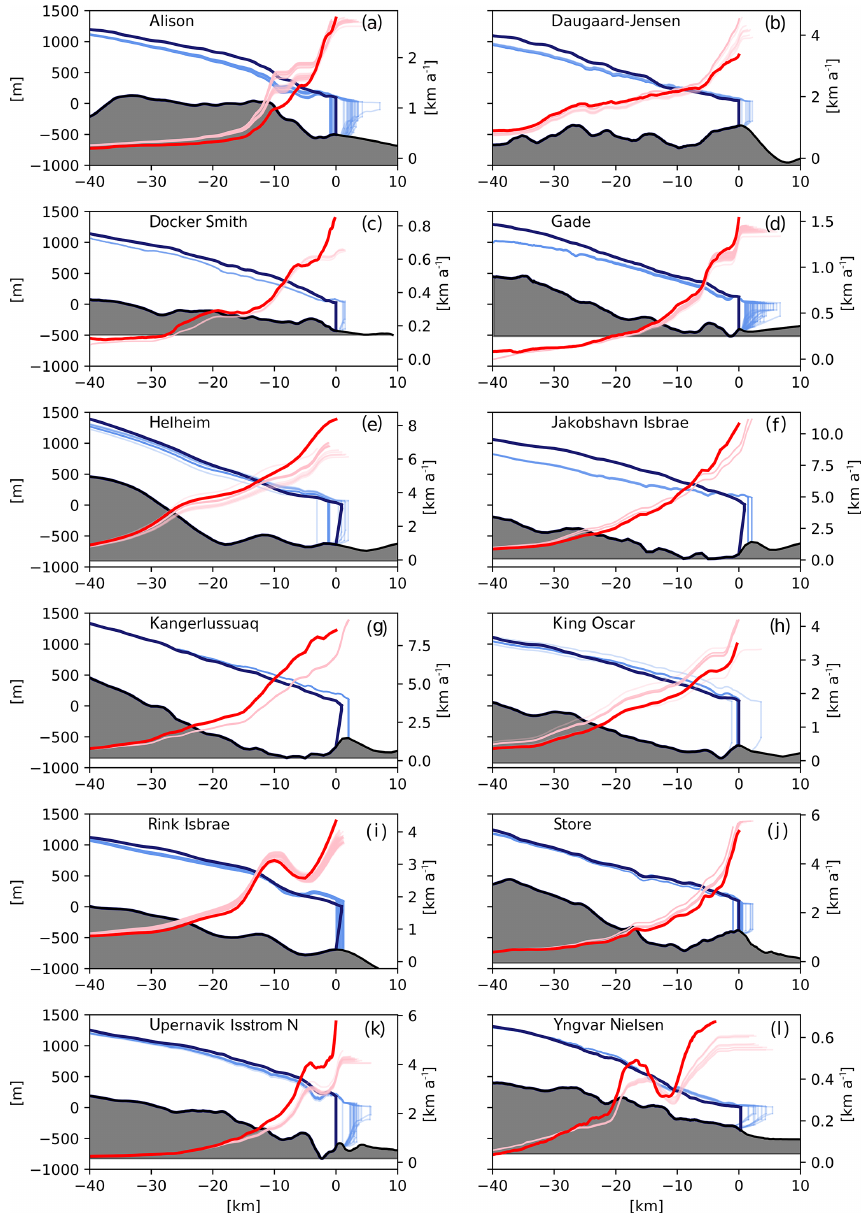
Figure 6. Simulated steady state after spin-up. Glacier elevation (light blue) and velocity profile (light red) for the last 40km to the grounding line depicted together with observational data (dark blue and dark red) by Morlighem et al. (2014) and Rignot and Mouginot (2012). Bedrock data are derived by the flux-weighted average over the whole catchment area. The number of simulations is given in Table S3,